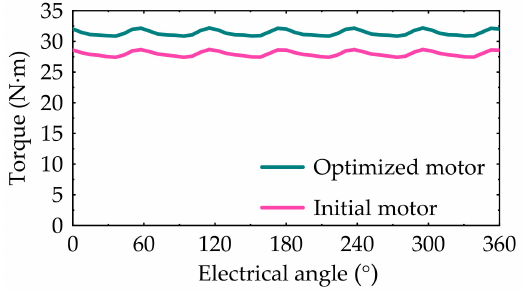
Figure 12. The electromagnetic torque of the initial motor and the optimized